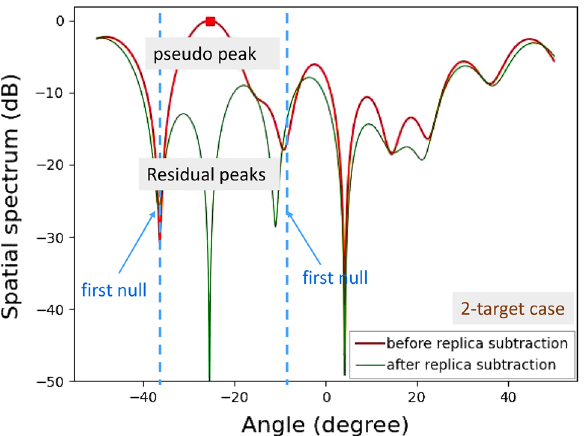
Figure 20. Experimental results for vertical angle estimations for a two-target case (20 m away with targets having different radar cross-sectional area).